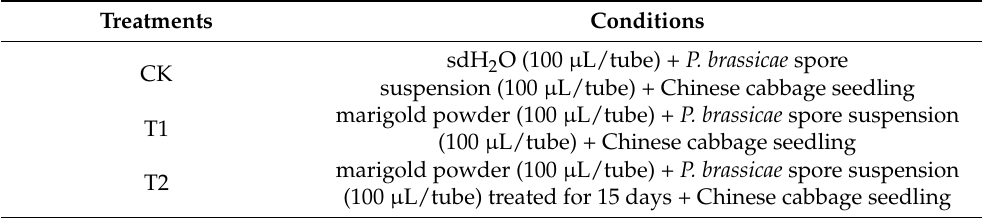
Table 3. Experimental conditions.